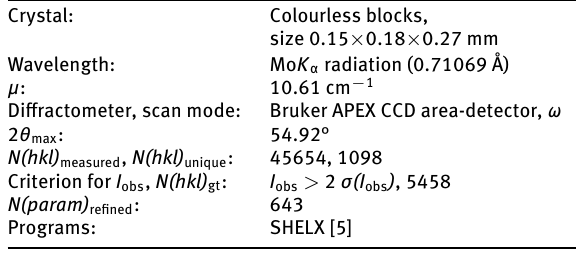
Table 1: Data collection and handling.